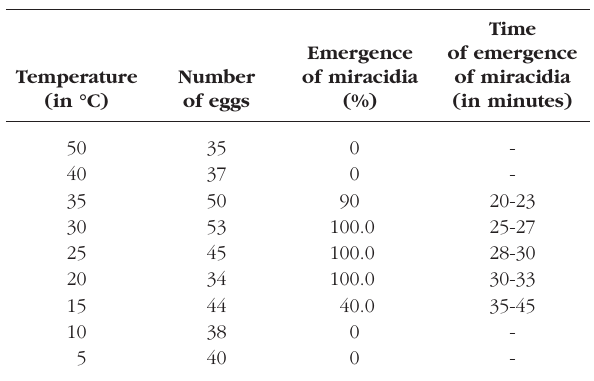
Fig. 2. – Dendritobilharzia loossi Skrjabin, 1924. a: consecutive stages of the embryo development; b: miracidium; c: the position of epithelial plates.